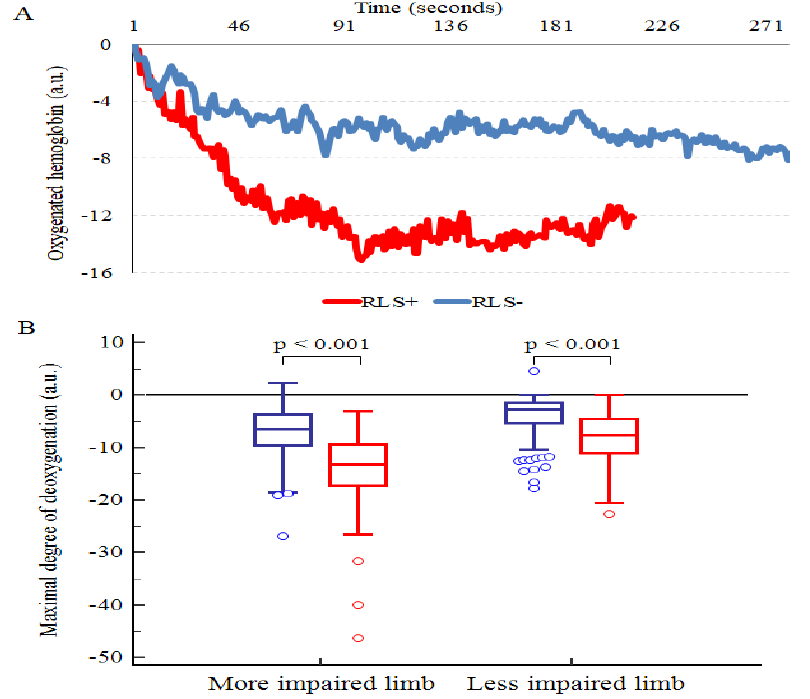
Figure 1. Mean oxyhemoglobin tracks for the more impaired limb ( A ) and maximal degree of deoxygenation of both limbs ( B ) in the two groups at baseline. Legend: red: RLS+; blue: RLS− .